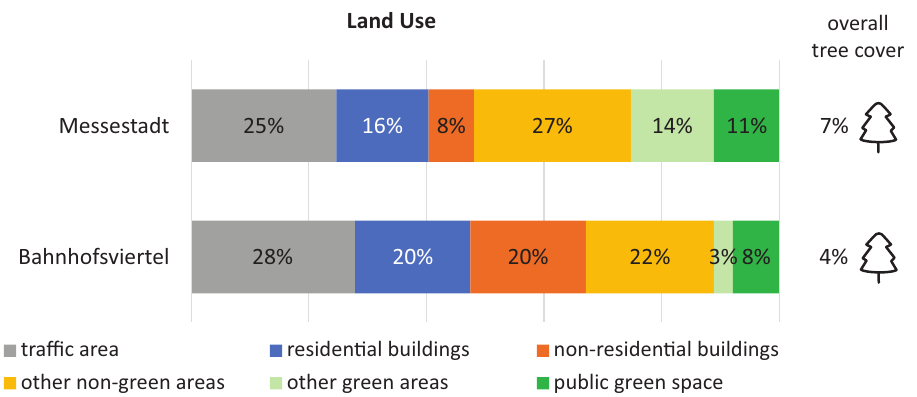
Figure 3. Land use for the study areas of Bahnhofsviertel and